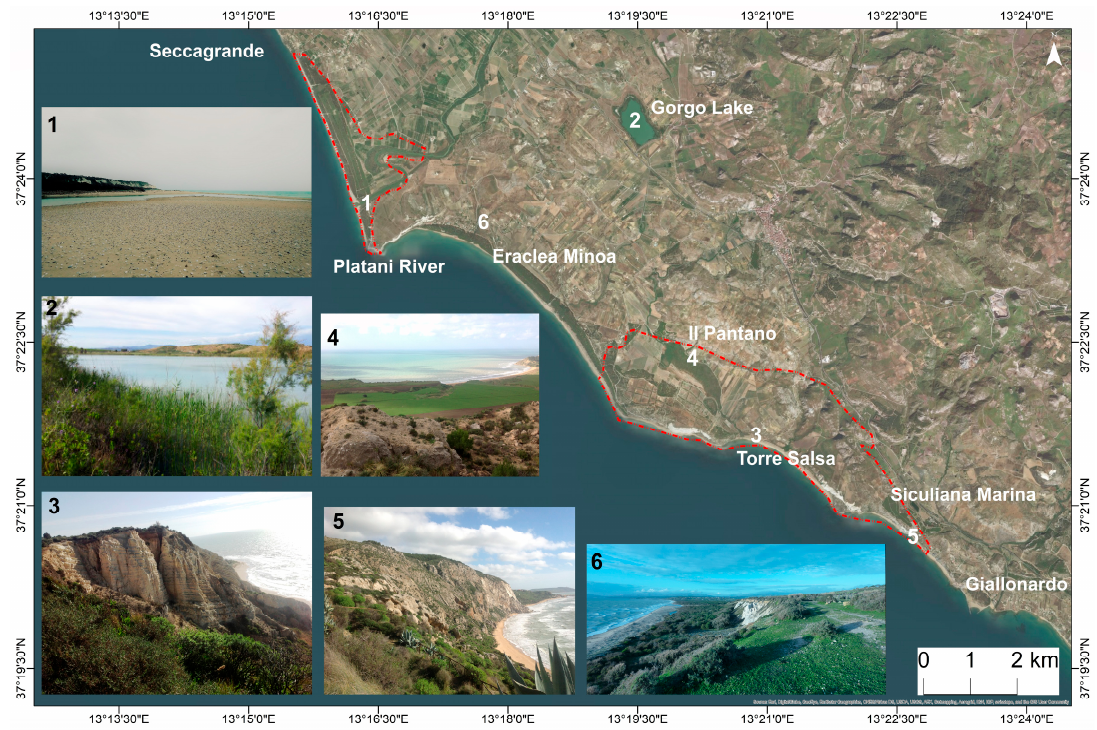
Figure 3. Outstanding geomorphological features of the Sicilian study area (GEOSIC): ( 1 ) sandy beach at the mouth of the River Platani; ( 2 ) Lake Gorgo hosted in a karst depression; ( 3 ) steep gypsum slopes and scrubland; ( 4 ) Il Pantano gypsum polje; ( 5 ) gypsum cliff affected by rock falls; ( 6 ) dune ridges and marine terraces. Red dashed-lines delimit respectively River Platani reserve in the north and Torre Salsa reserve in the southeast.